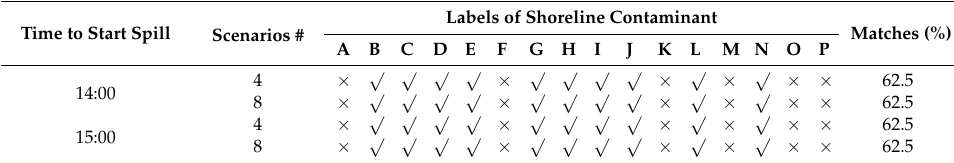
Table 5. Examples of shoreline contaminant comparison. The simulated results were compared with observation